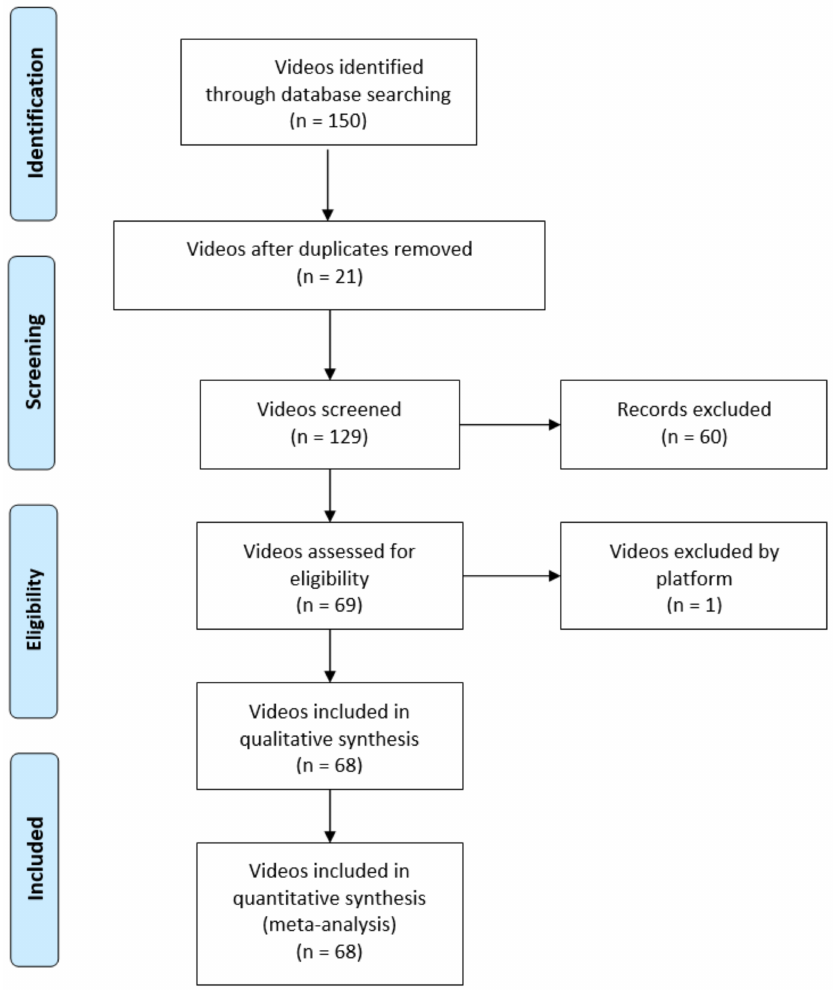
Figure 1. Flow diagram. From